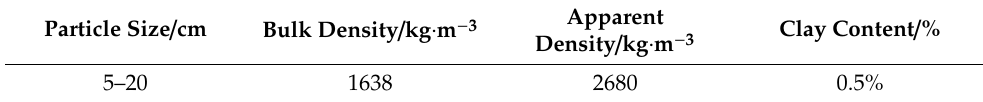
Table 3. The properties of coarse